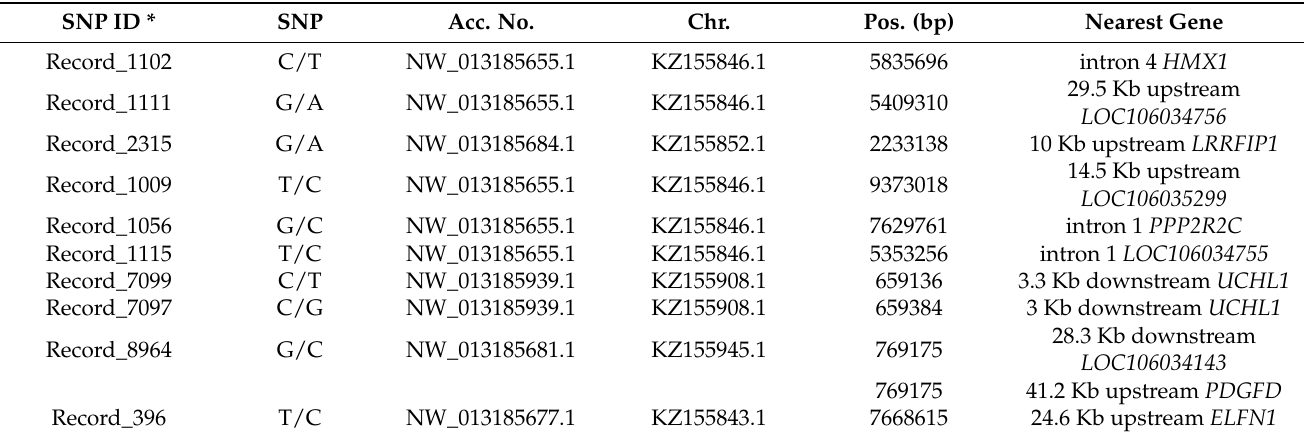
Table 4. Annotation of genes harboring SNPs associated with the marketing weight of male